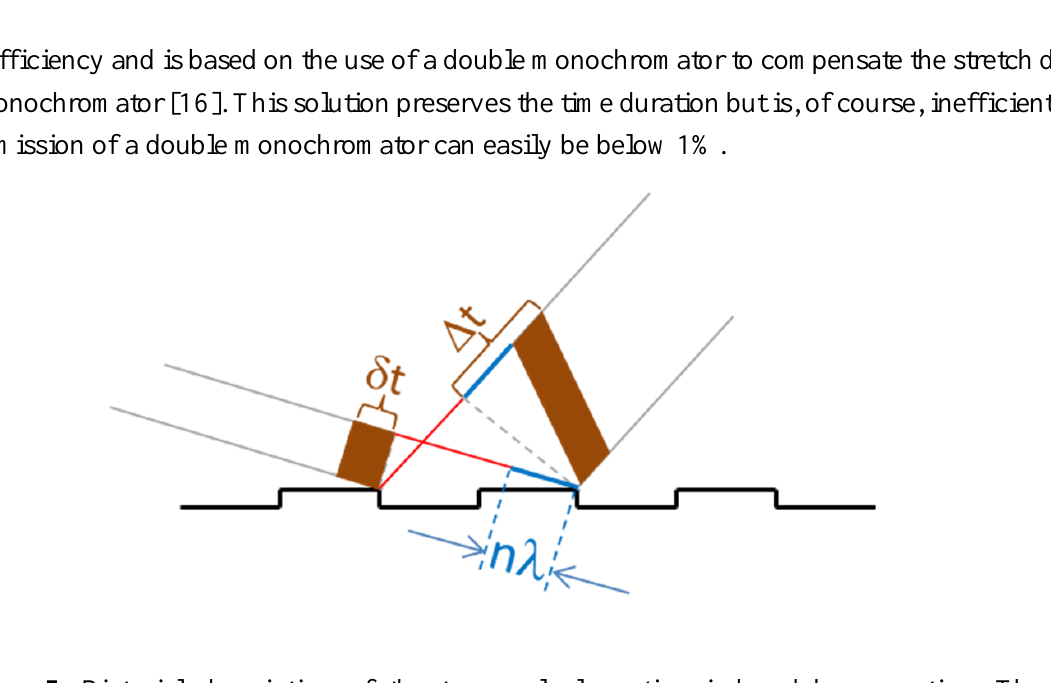
Figure 5. Pictorial description of the temporal elongation induced by a grating. The incoming beam has temporal duration δt. The difference in path between the rays must be a multiple of the wavelength. Therefore, different parts of the photon bunch travel different path lengths. As a result, the length of the beam, after diffraction from a single groove is ∆t. A different approach is the use of a grating in conical diffraction. In this configuration the gratings line are parallel to the beam and not perpendicular. The efficiency can be as high as 50% and, more important, the number of illuminated grooves is lower. Of course, the ultimate resolution is also lower than in the standard configuration, but, properly designed, can produce a transform-limited monochromatic beam. The disadvantage of the conical configuration is the mechanical complexity of the system. For further details, the article by Frassetto et al. in this same issue provides interesting reading about monochromators in conical diffraction